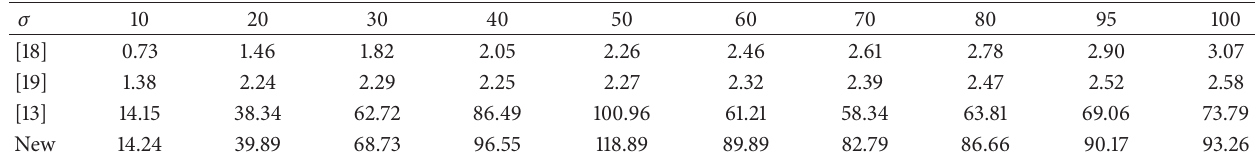
Table 6: IEF of different algorithms with different Gaussian noise levels for Miss America video sequence.